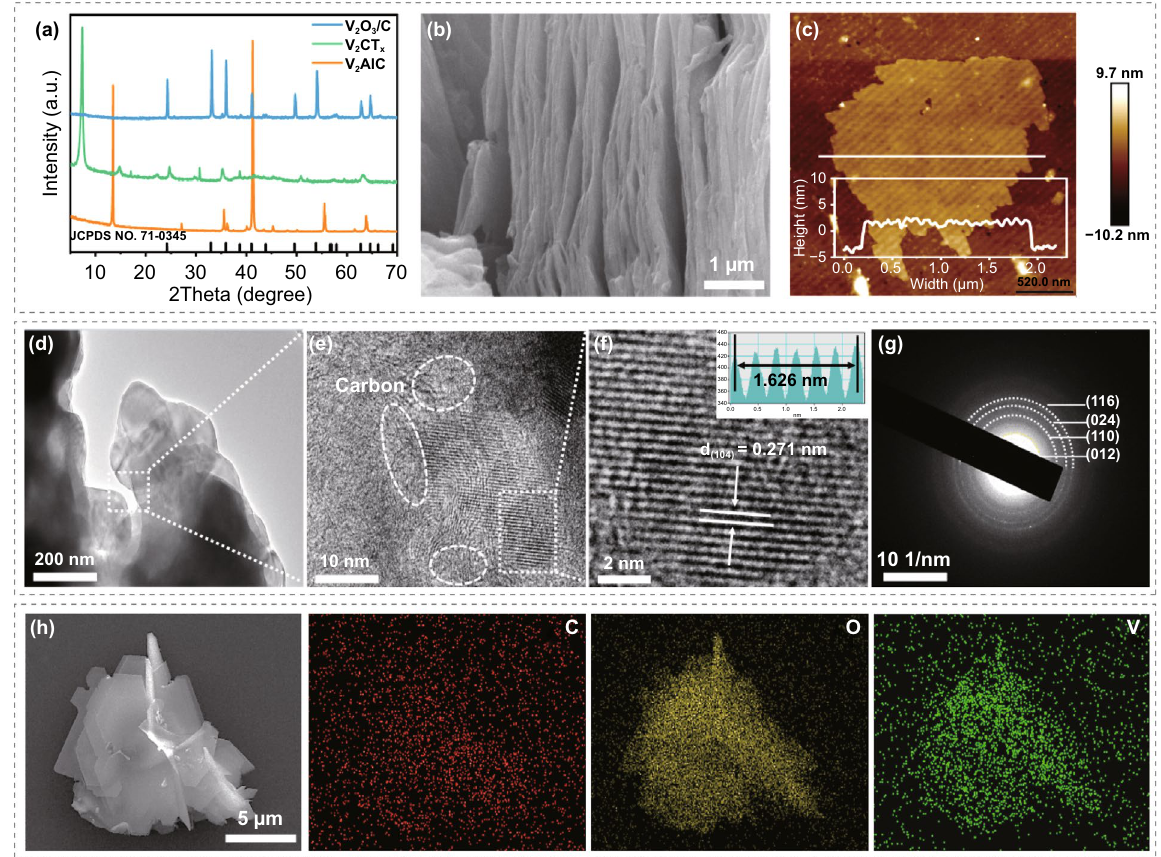
Fig. 2 a XRD pattern of V 2 AlC, V 2 CT x MXene and V 2 O 3 /C nanosheets. b FESEM image of V 2 CT x MXene. c AFM image of the V 2 O 3 /C nanosheets. d TEM image and e , f corresponding HRTEM images and g SAED image of the V 2 O 3 /C nanosheets. h EDS elemental mapping of the V 2 O 3 /C